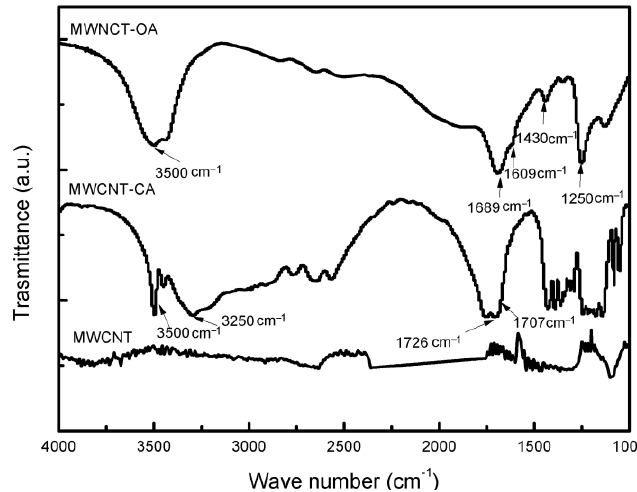
Figure 2. FTIR spectra of MWCNT, MWCNT-CA and MWCNT-OA.